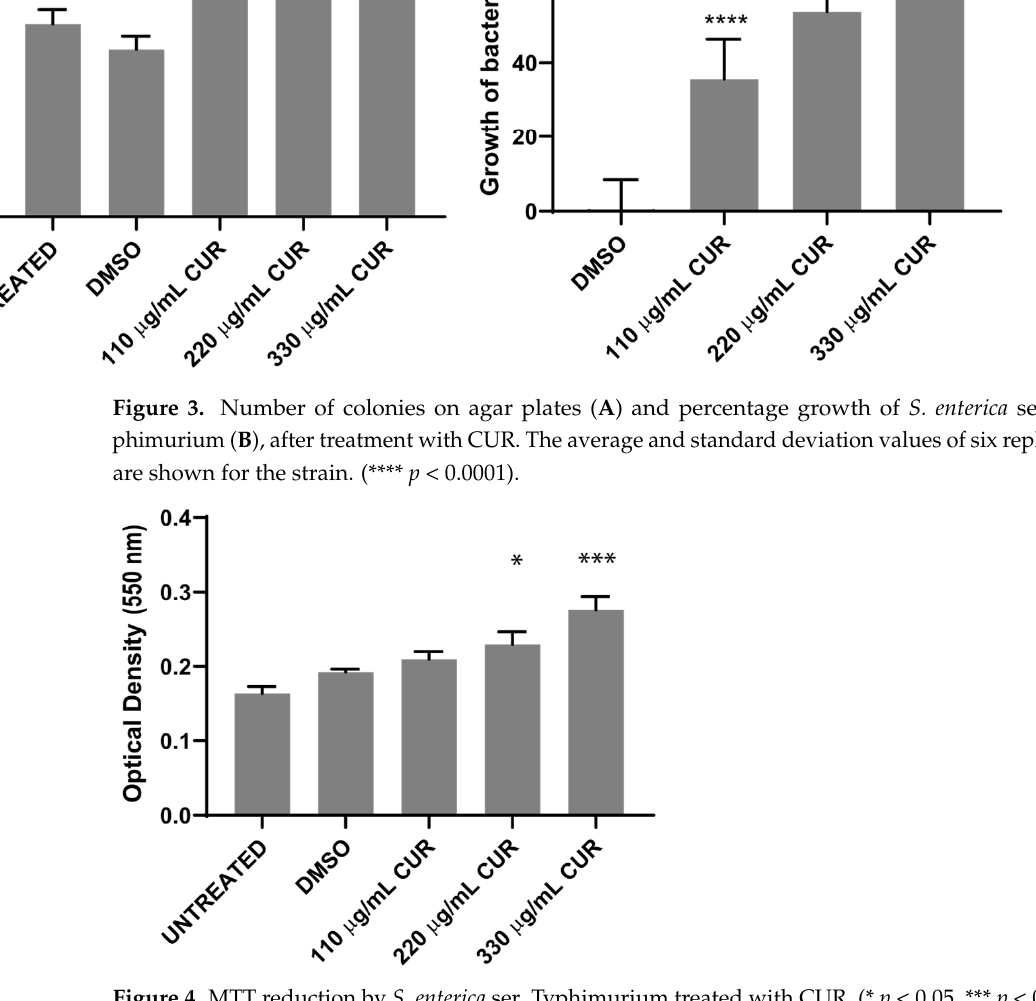
Figure 3 . Number of colonies on agar plates ( A ) and percentage growth of S. enterica ser. Typhi- murium ( B ), after treatment with CUR. The average and standard deviation values of six repli- cates are shown for the strain. (**** p < 0.0001) .